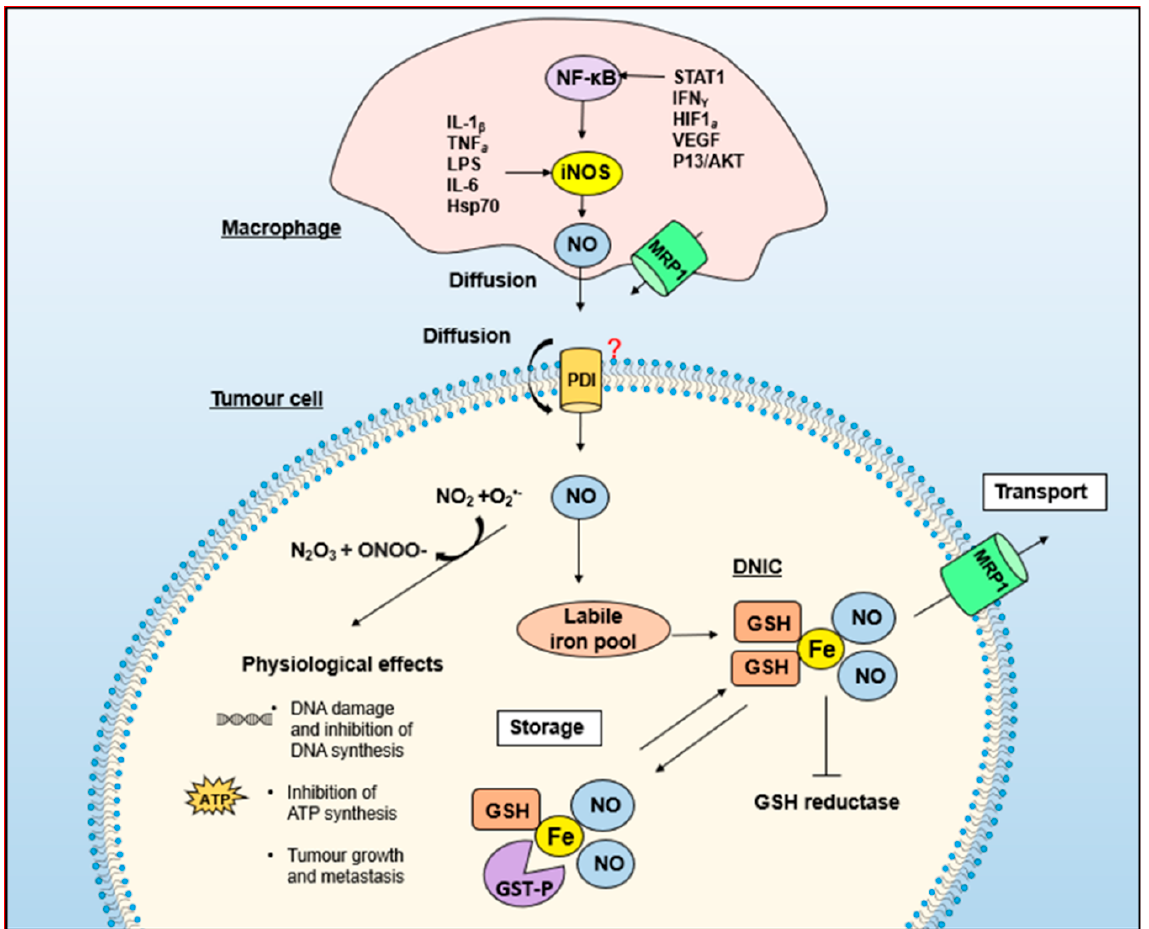
Figure 7. Proposed mechanisms involved in inhibiting tumor cell metabolism after co-cultivation of tumor cells with NO-generating activated macrophages. Cytokines and other agents (LPS, IFN γ , STAT1, and TNF- α , etc.) promote the synthesis of iNOS-derived NO in macrophages [16]. NO can then diffuse from the cell or form a DNIC complex and be actively transported out of the cell [132,135]. NO is transported into the target tumor cell via diffusion or actively by protein disulfide isomerase (PDI) through trans-nitrosylation [177]. NO within cells has several physiological effects [178,179] and can react with iron and GSH to create DNICs. MRP1 functions to export DNICS out of the cell to facilitate iron and GSH efflux, which results in iron depletion and inhibition of tumor cell proliferation.